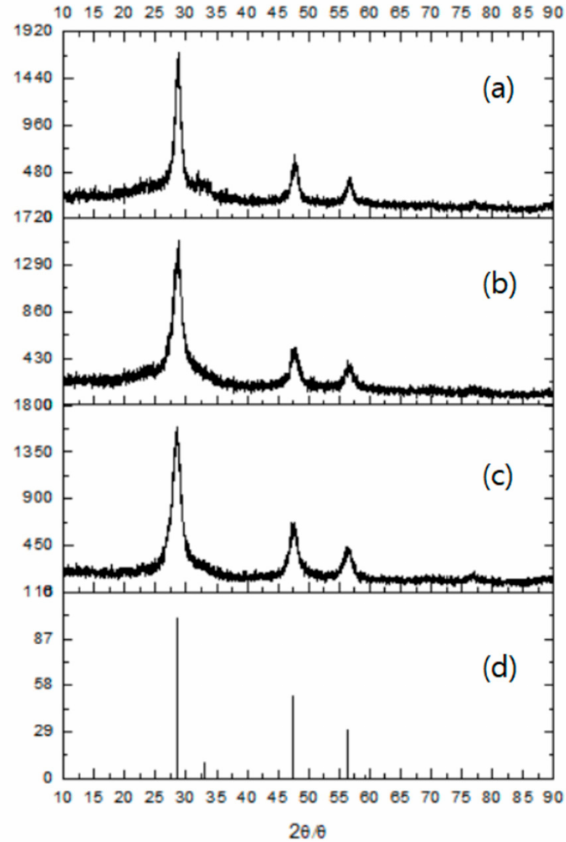
Figure 4. XRD pattern diagrams of ( a ) Gly-ZnS:Mn, ( b ) Ala-ZnS:Mn, and ( c ) Val-ZnS:Mn NPs, and ( d ) a reference bulk ZnS solid in a zinc blende